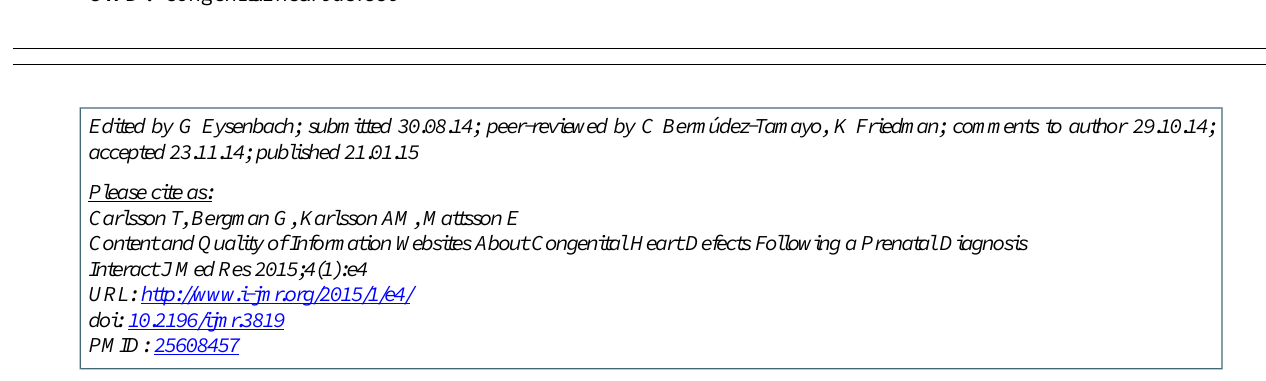
CHD: congenital heart